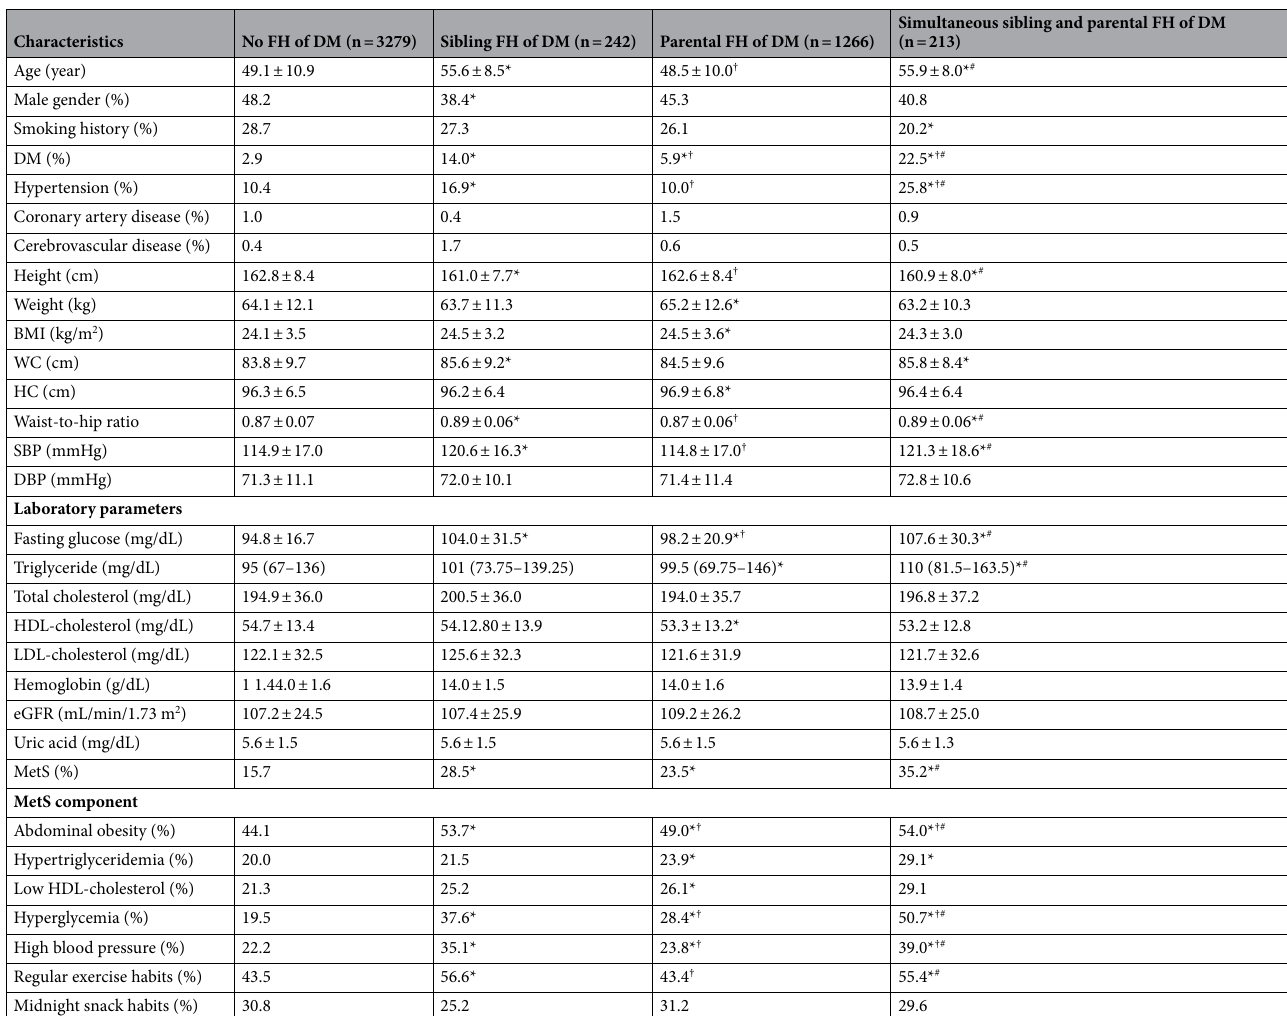
Table 1. Comparison of clinical characteristics among study groups according to sibling and/or parental FH of DM. FH family history, DM diabetes mellitus, BMI body mass index, WC waist circumference, HC compared with no FH of DM. † p < 0.05 compared with sibling FH of DM. # p < 0.05 compared with parental FH of